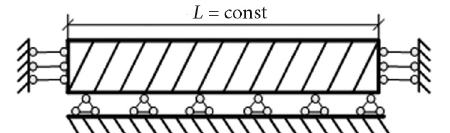
Fig. 1. Design model for the calculation of stresses in asphalt concrete pavement before cracking on a solid basis